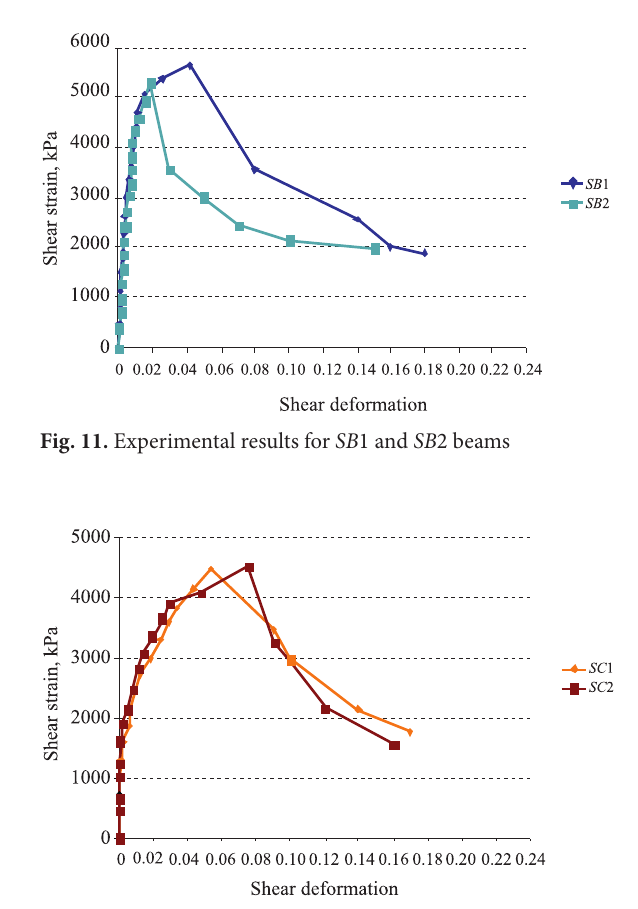
Fig. 12. Experimental results for SC 1 end SC 2